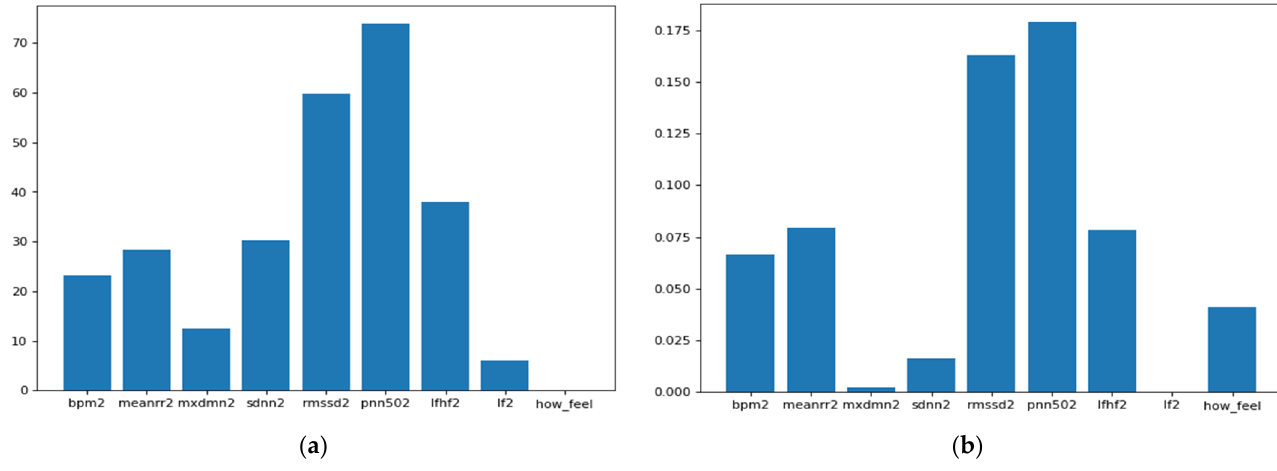
Figure 6. This Figure shows the features ranking according to their importance to the target through two different feature selection techniques which are: ( a ) ANOVA-F and ( b ) Mutual Information.